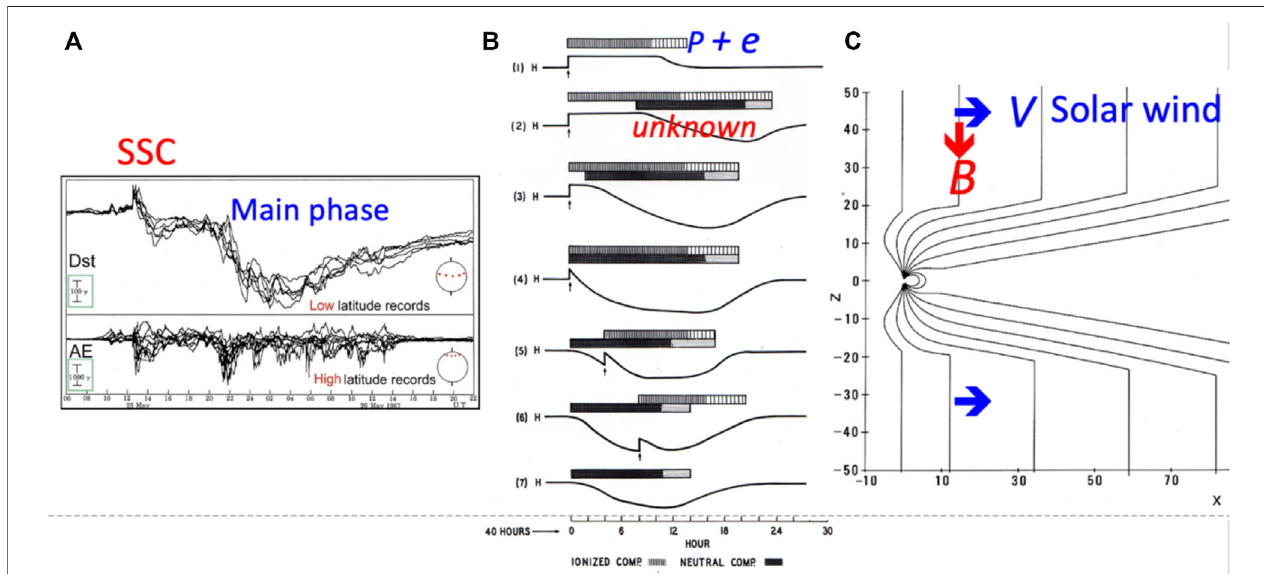
FIGURE 1 | (A) Magnetic records of a number of stations from both low latitudes (upper) and low latitudes (lower) of a geomagnetic storm (only the horizontal component); the circular insert show approximate location of the observatories. They are typical geomagnetic records, and it can be considered as a standard type of geomagnetic storm. (B) It illustrates a great variety of geomagnetic storms; (p + e) indicates the case, in which the solar wind consists of only protons and electrons; “ unknown ” indicates thatitwasthought thatthesolarwind had someunknownparameter causingthemainphase. (C) Thelinked magnetic fi eldbetween IMFand magnetospheric fi eld; this interaction constitutes the solar wind-magnetosphere dynamo, proving the power fo the main phase and the aurora.